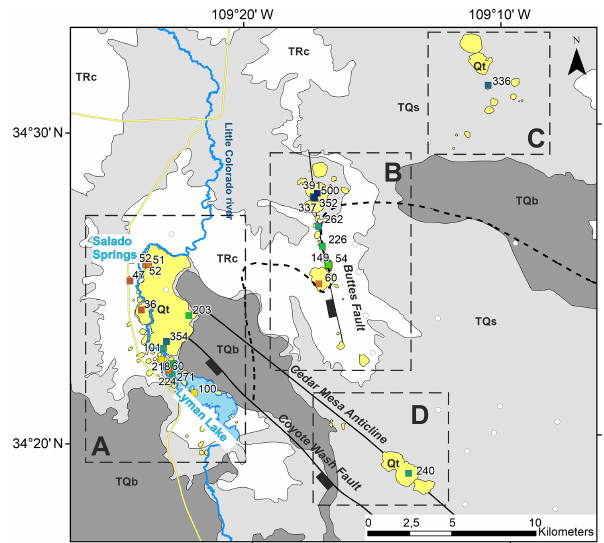
Figure 4. Geological map illustrating the travertine deposits of the St. Johns Dome area. Coloured squares indicate available U–Th dat- ing locations with respective ages in thousands of years (Miocic et al., 2019a; Priewisch et al., 2014); see Fig. 2 for legend. Four clus- ters of travertine mounds can be identified: cluster A, which spreads from Lyman Lake to Salado Springs, is at the tip of the Coyote Wash Fault; cluster B follows the trace of the Buttes Fault; clus- ter C is not related to a known structural feature and is located north of the present-day CO 2 reservoir; and cluster D is located on the crest of the Cedar Mesa Anticline. Note that ages along the Buttes Fault (cluster B) generally get younger from north to south, whilst the travertines of cluster A show a wide range of ages without an obvious spatial correlation with